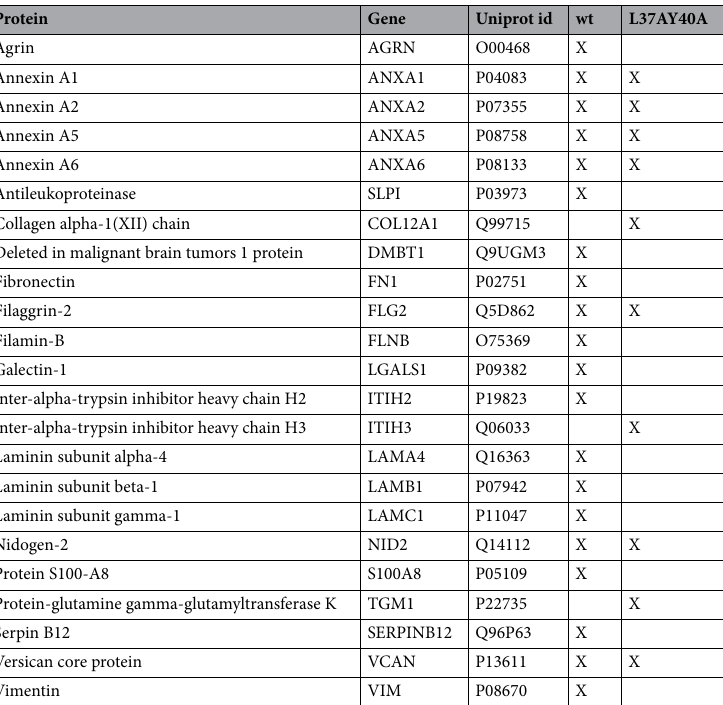
Table 2. ECM-associated proteins present at lower levels in conditioned media from HCASMC exposed to wt or L37AY40A AN compared to cells not exposed to AN. A full list of all regulated proteins is available in Supplementary Data